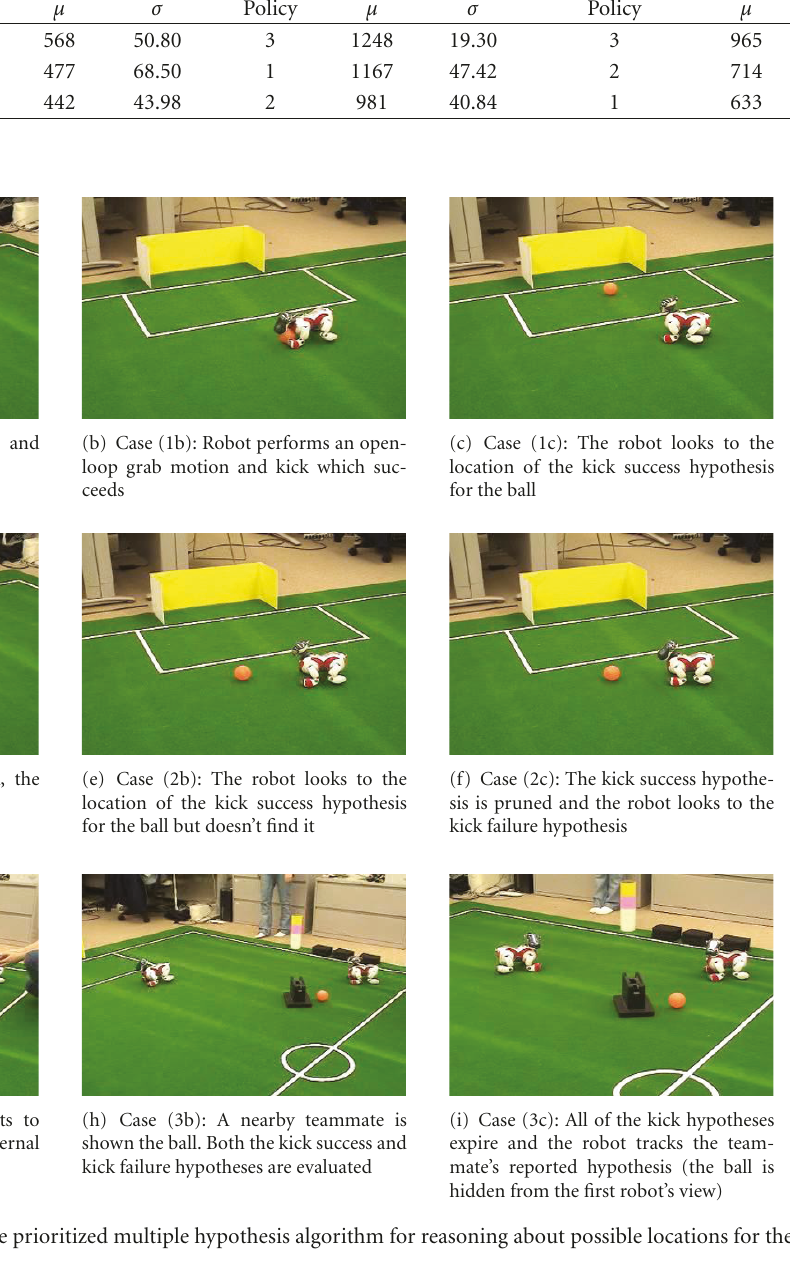
which filter should be updated with the new